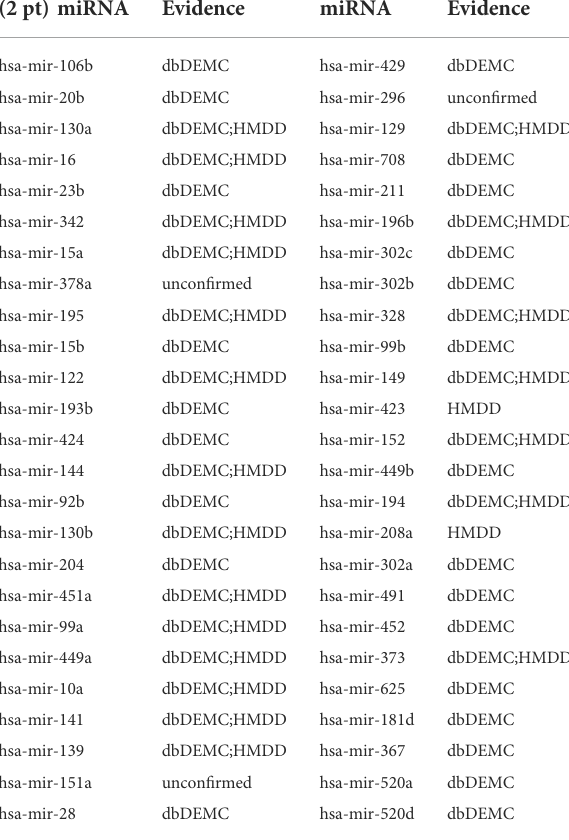
TABLE 2 The top 50 potential miRNAs associated with lung